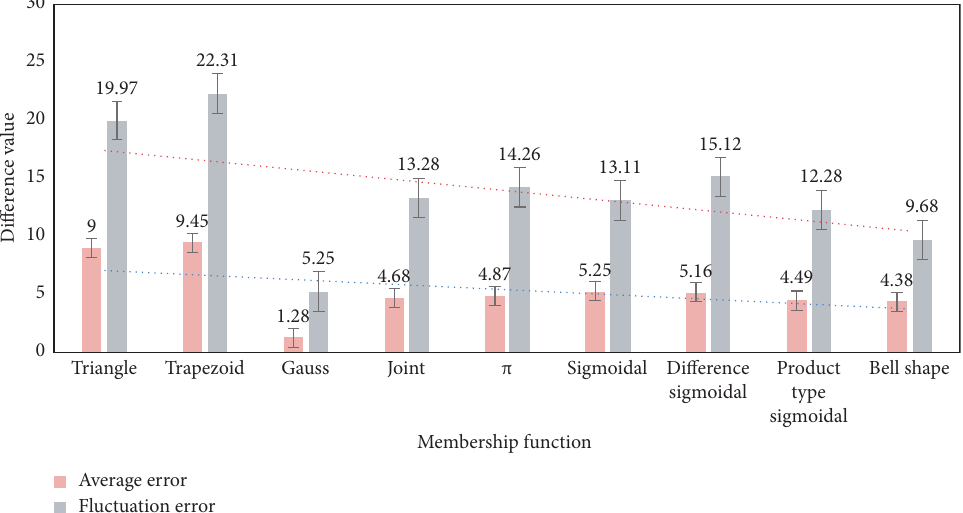
Figure 5: Comparison of average error and fluctuation error of different membership